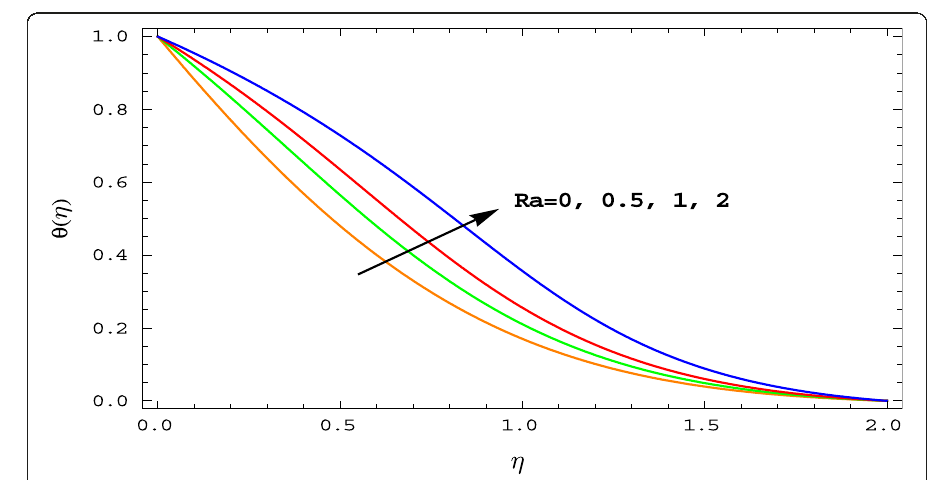
Fig. 15 Fluid temperature with increasing of the radiation parameter ( Ra